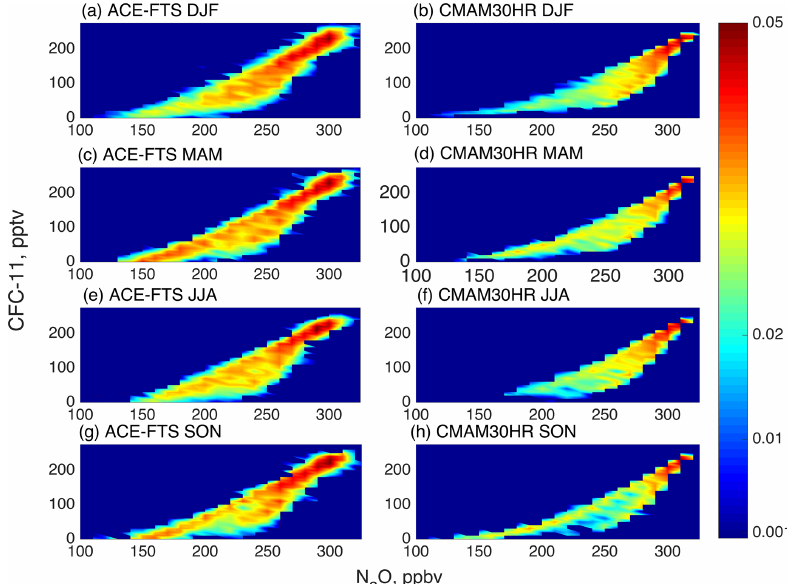
Figure 14. Tropical JPDFs of N 2 O–CFC-11, as described in the text, separated by season. Only stratospheric ACE-FTS observations (left column) and CMAM30HR simulations (right column) within the height-dependent tropical turnaround latitudes have been